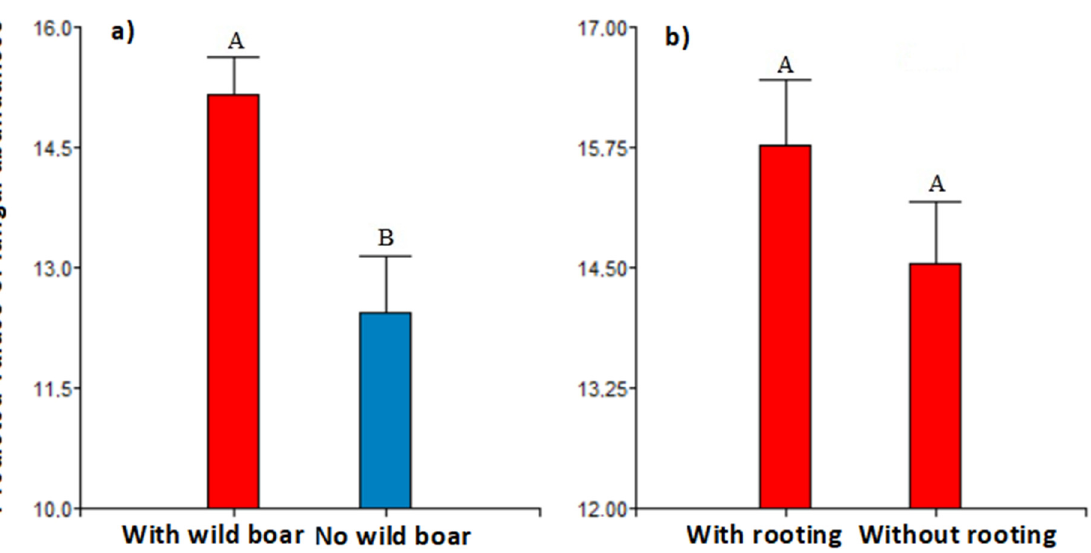
Figure 3. Overall predicted values of the abundance of fungal sporocarps for areas with wild boar and without wild boar ( a ) and disturbed and undisturbed regions ( b ). Bars indicate the standard error. Different letters indicate significant differences among groups according to Fisher’s LSD post-hoc tests ( p < 0.05). Table 2. Overall abundance (model 2) of fungal sporocarps, as responses to the presence of wild boar and wild boar rooting (three treatments), analyzed with GzLM. Coefficients for the level of fixed factors were calculated using reference values of the treatment ‘wild boar’ (with rooting) in the variable “treatment”, ‘rocky’ in the variable “type of soil”, ‘open’ in the variable “environmental type” and ‘wet’ in the variable “soil humidity”. (* p < 0.05; *** p < 0.001). df F